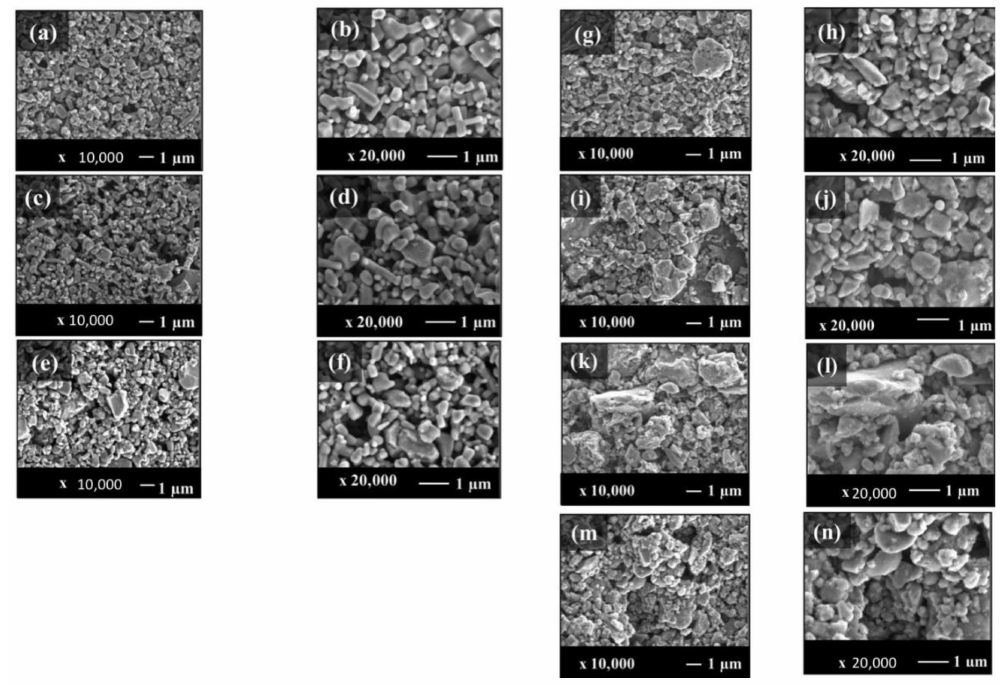
Figure 1. SEM images of ( a ) 100 wt% ZnO ˆ 10,000 magnification, ( b ) 100 wt% ZnO ˆ